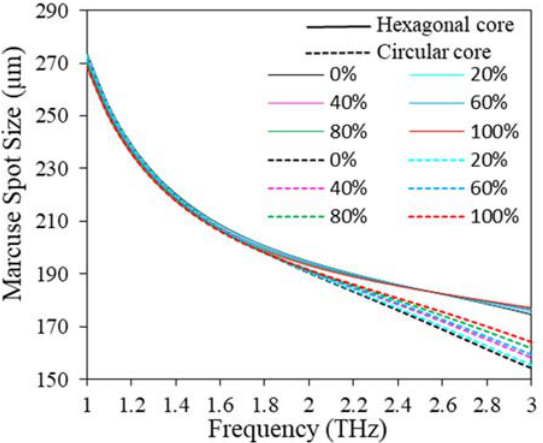
Figure 14. MSS variation with the change of frequency for D = 643.34 μ m, D c = 280 μ m, t = 15 μ m, z = 10 μ m.